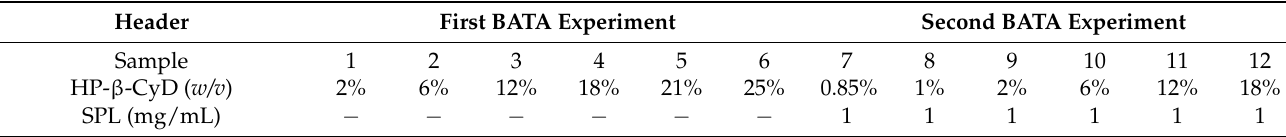
Table 1. Concentrations of HP- β -CD and SPL used in both BATA experiments.